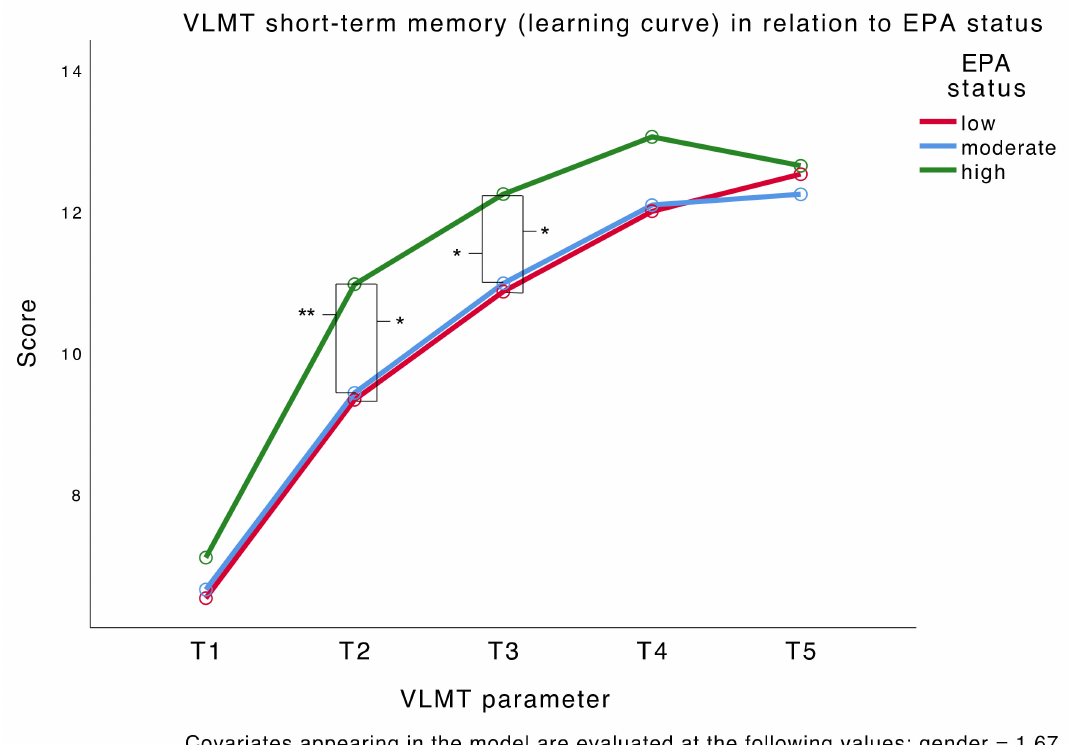
Figure 1. VLMT learning curve in relation to EPA status. N = 107. * p < 0.05, ** p <